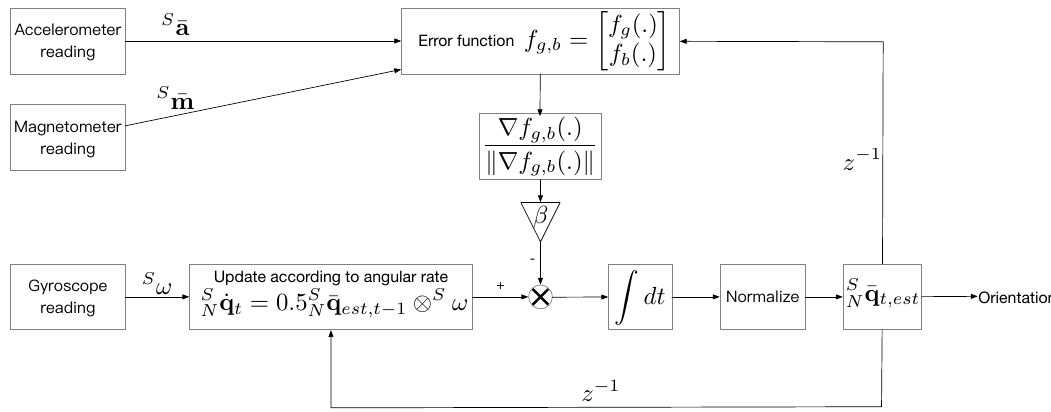
Figure 3. The processing of orientation estimation using readings from the accelerometer, magnetometer and gyroscope.